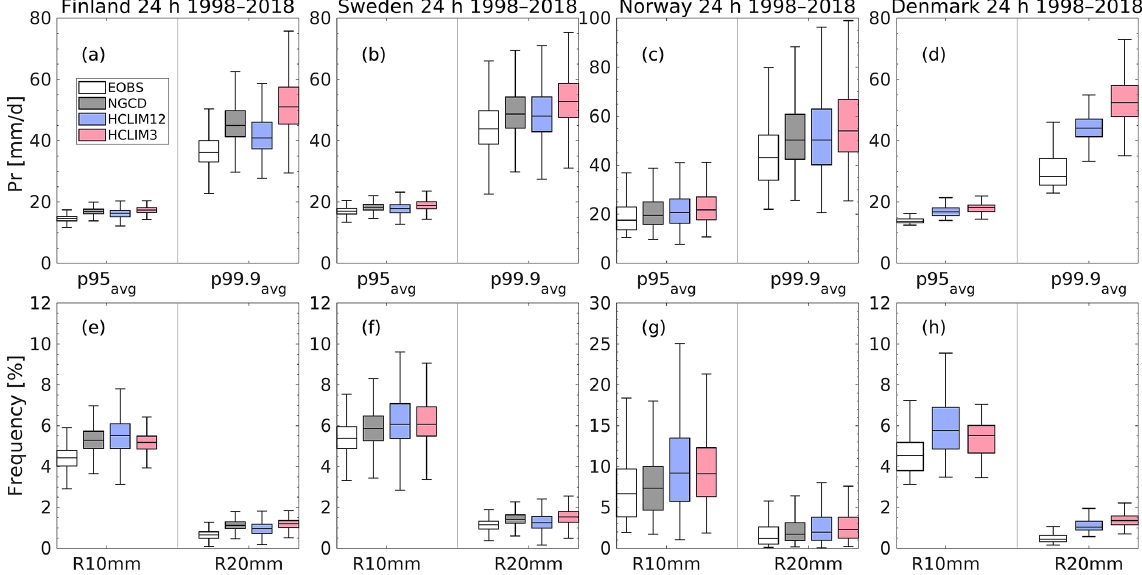
Figure 3. (a–d) Average daily precipitation (Pr) over the 95th and 99.9th percentiles (p95 avg and p99 . 9 avg ) in (a) Finland, (b) Sweden, (c) Norway, and (d) Denmark in HCLIM12, HCLIM3, and observational datasets. (e–h) The frequency of days with heavy (R10mm) and very heavy (R20mm) precipitation in HCLIM12, HCLIM3, and observational datasets in (e) Finland, (f) Sweden, (g) Norway, and (h) Denmark. The data are presented on their native grids. The central mark in the boxplots is the median, while the limits of the boxes represent the 25th percentile (Q1) and the 75th percentile (Q3), representing the interquartile range (IQR). The whiskers represent the range from Q1–1.5IQR to